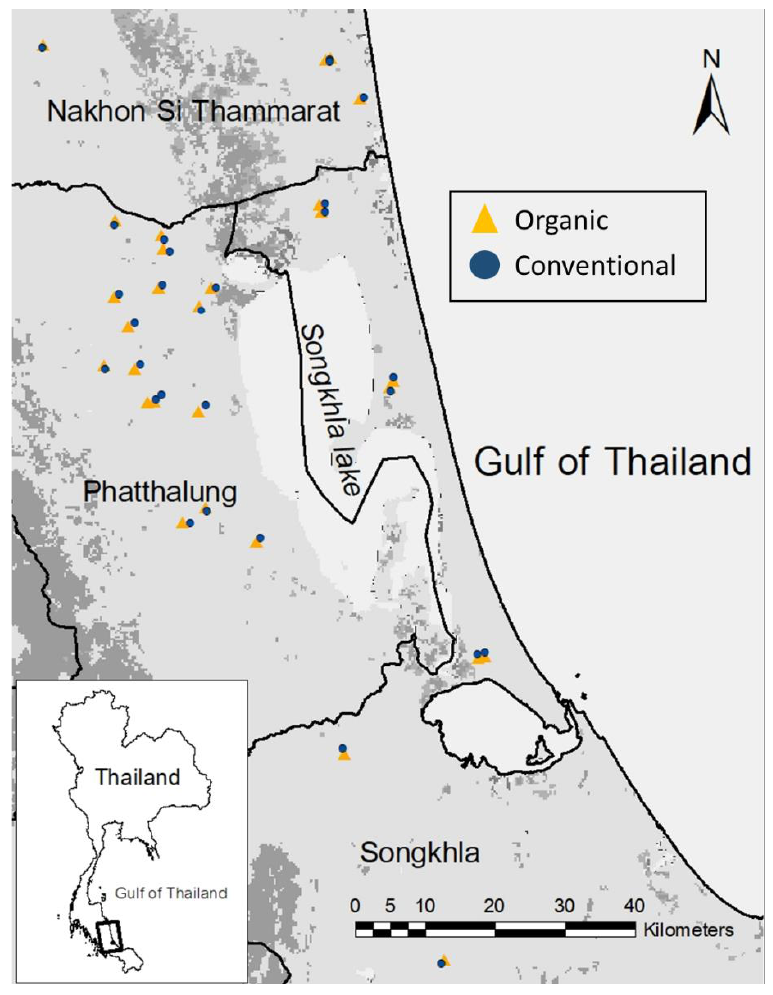
Figure 1. Locations of the 28 matched organic – conventional rice field pairs in the Songkhla Lake Basin, Thailand, where we conducted bat and aerial insect surveys. Organic sites are shown in yel- low triangles, and conventional sites are shown in blue circles. Matched organic – conventional pairs had similar field sizes and proportions of agricultural area; forest and seminatural habitat; urban area; and water bodies within 1, 2, and 3 km radii of the rice